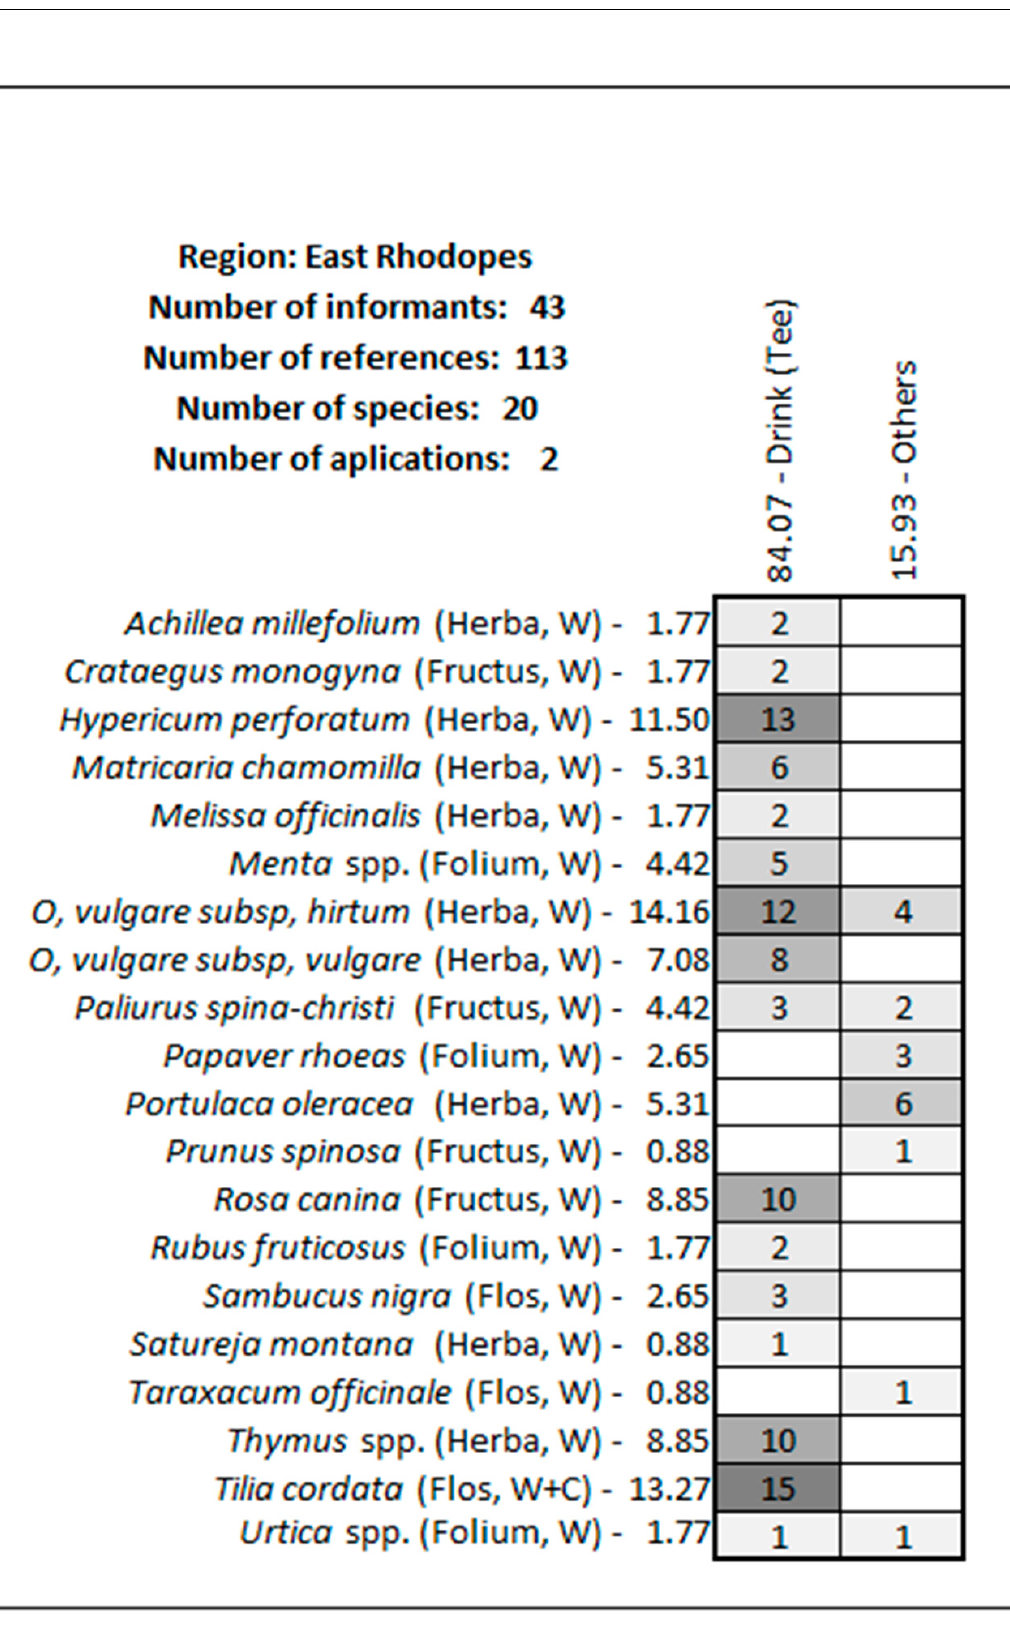
Figure 10. Nomogram of the medicinal plants with prophylactic application in the East Rhodopes Legend: abscissa/horizontal axis of the nomograms depicts the conditions for which the informants apply the medicinal plants, as well as the way of processing the plant raw material; ordinate vertical axis shows the medicinal plants Genus species (used part, wild/cultivated)—UV (%).